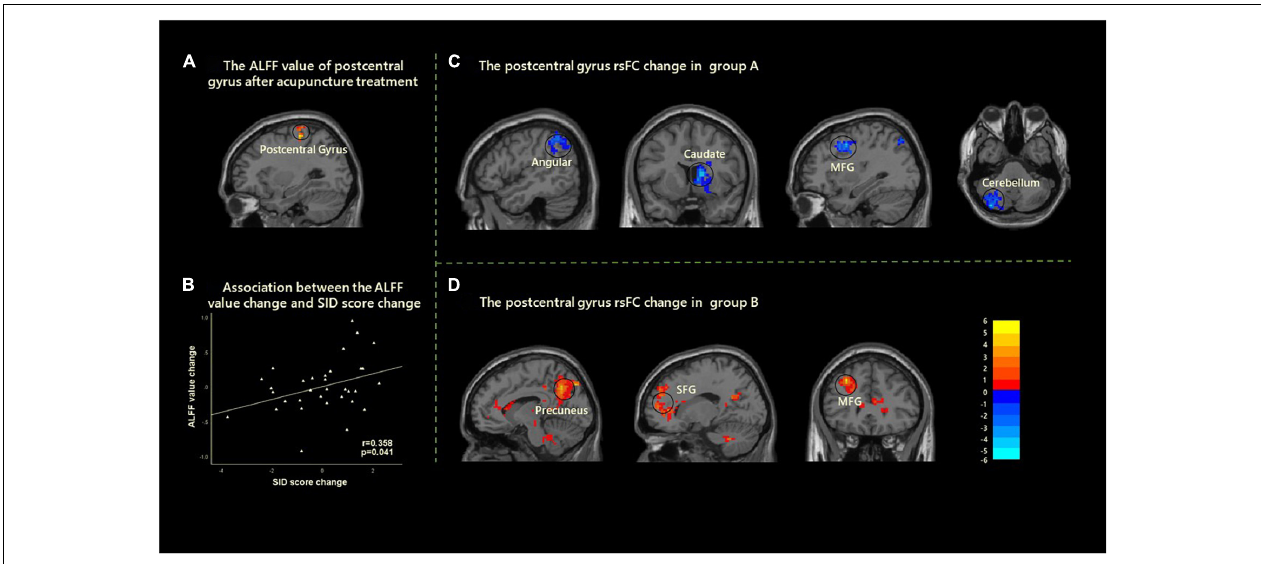
FIGURE 2 | Cerebral activity changes induced by the acupuncture stimulation in two groups. (A) A significantly increased ALFF was found in the left postcentral gyrus after acupuncture treatment. (B) Correlation analysis showed that the change of ALFF value in left postcentral gyrus and the improvement of SID were positively correlated with age and gender as covariates ( r = 0.358, p = 0.041). (C) After acupuncture treatment, the decreased rsFC between the left postcentral gyrus with angular, caudate, MFG, and cerebellum were found in group A. (D) After acupuncture treatment, the increased rsFC between the left postcentral gyrus with precuneus, SFG, and MFG was found in group B. ALFF, amplitude of low-frequency fluctuation; rsFC, resting-state functional connectivity; MFG, middle frontal gyrus; SID, Symptom Index of Dyspepsia; SFG, superior frontal gyrus.